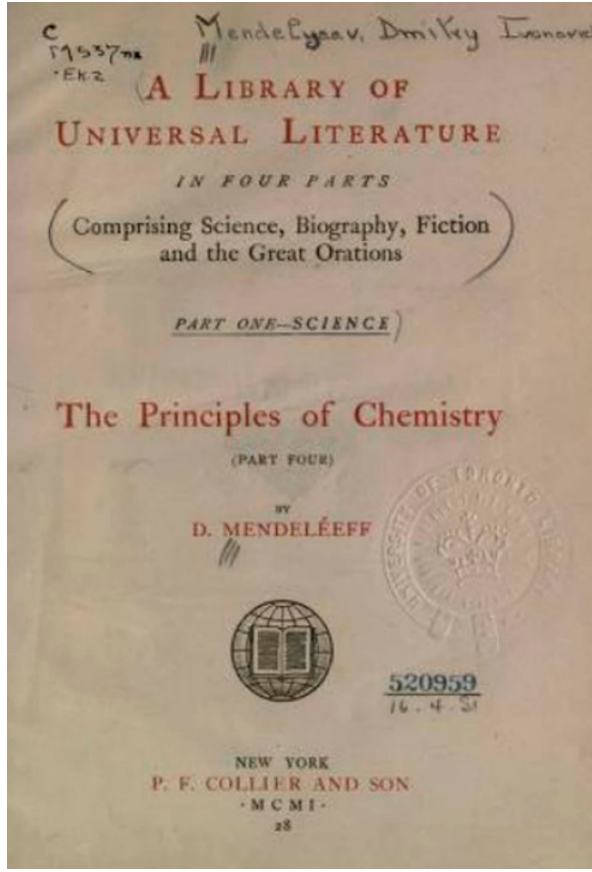
Figure 6. Title Page of a 1901 American reprinting of the the Eng- lish edition of Mendeleev’s “Principles of Chemistry.” 7